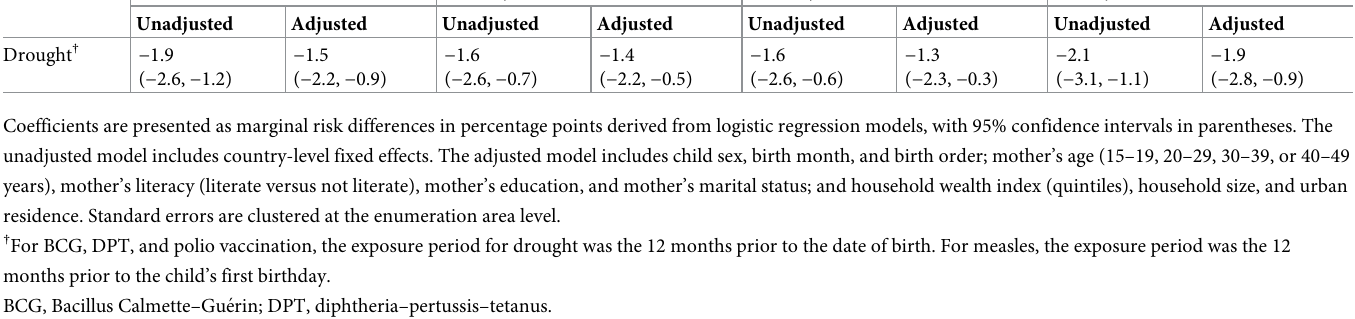
Table 3. Associations between drought and vaccination among children born in 2011–2019 ( n = 137,379). Exposure